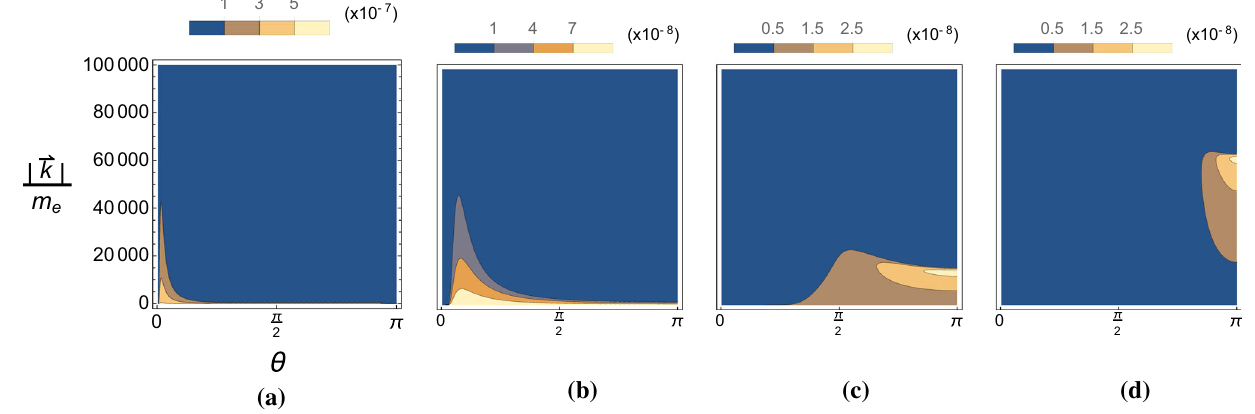
Fig. 9 The scalar yield, P + , is plotted as a function of the angle and momenta of the emitted ALP in a Gaussian background with m φ = 0. a χ = 0 . 1, b χ = 1, c χ = 10, d χ = 40 p , 0 p , 0 p , 0 p , 0